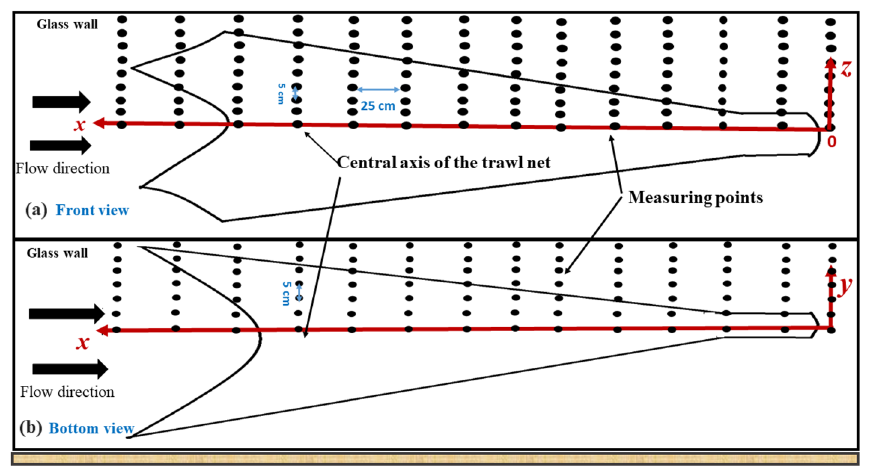
Figure 4. ECVM measurement point locations as shown in black circles in ( a ) Front view and ( b ) Bottom